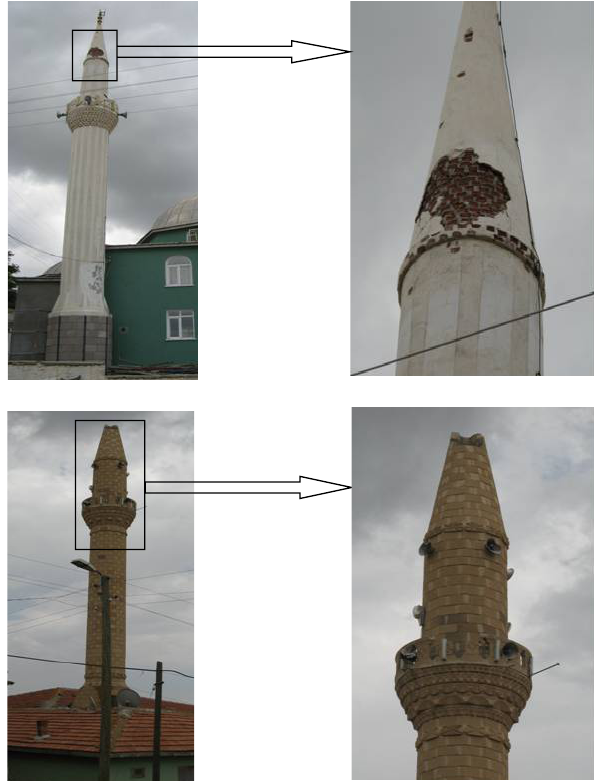
Fig. 20. Examples of damages on the slender masonry buildings. Fig. 20 Examples of damages on the slender masonry buildings